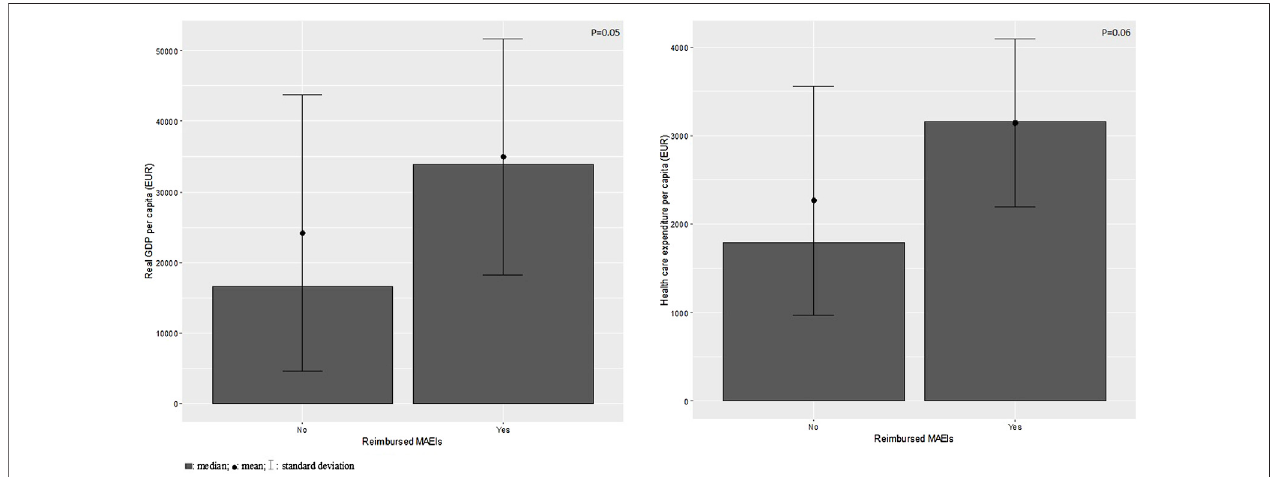
FIGURE 2 | Association between country income and health care expenditure, and the availability of reimbursed medication adherence enhancing interventions across European countries. GDP: gross domestic product; MAEI: medication adherence enhancing intervention.